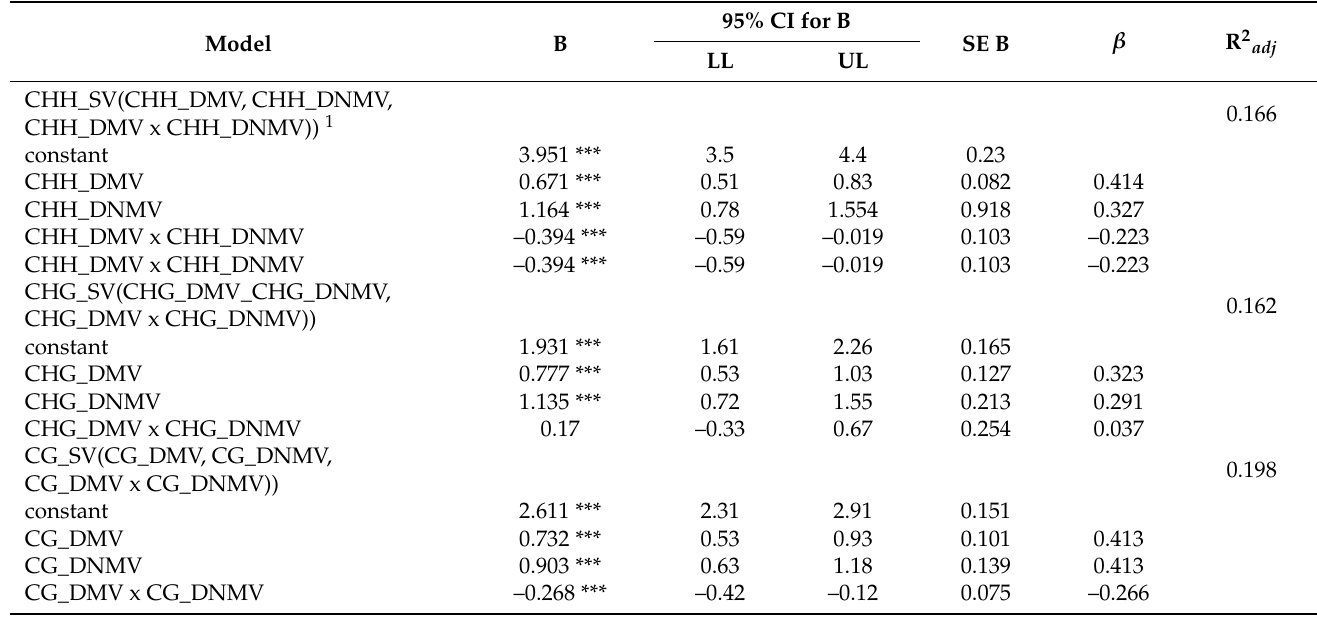
Table 5. Multiple regression results verifying whether DNM and DNMV in different DNA sequence contexts explain sequence variation related to the respective asymmetric and symmetric contexts without focusing on the role of groups of regenerants derived from D68, D69, D70, and D72 donor plants.